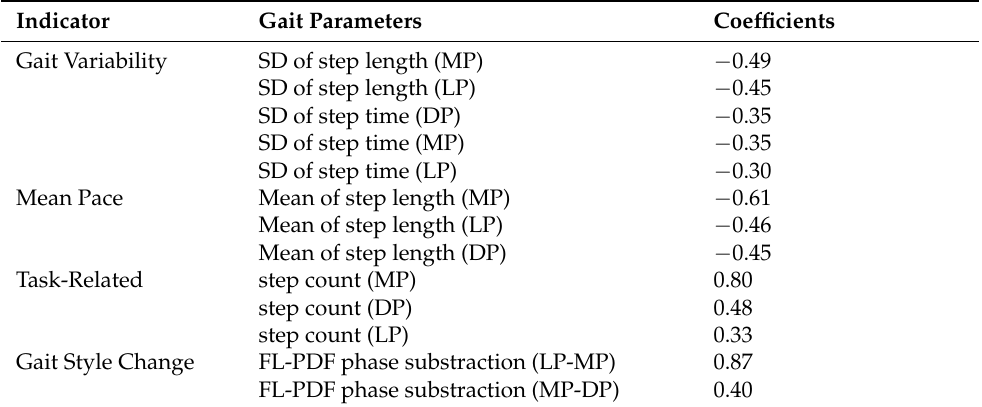
Table 2. The results of the Principal Component Analysis (PCA) analysis for each group of gait parameters (indicators).